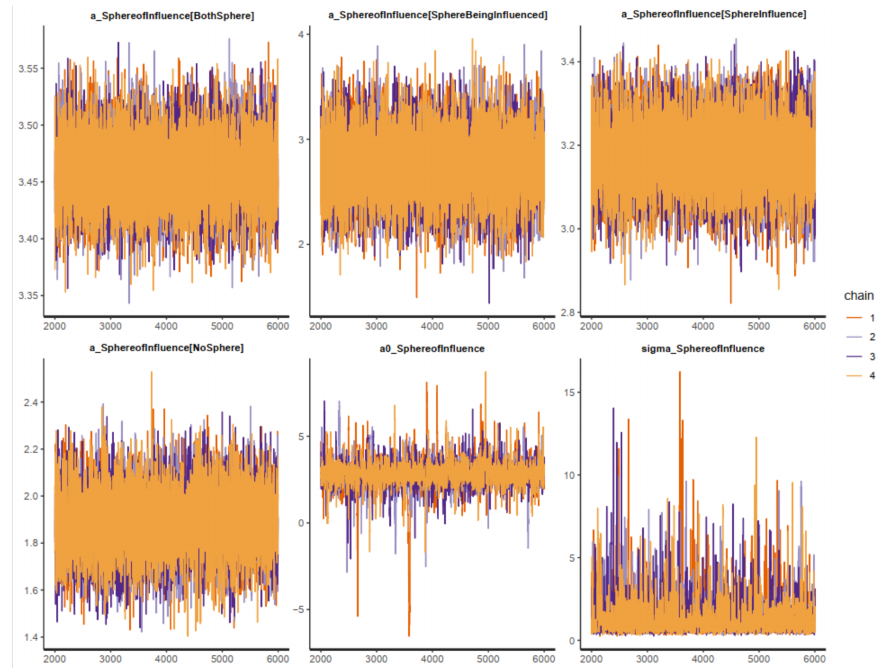
Figure A1. Model 1 (cid:48) s trace